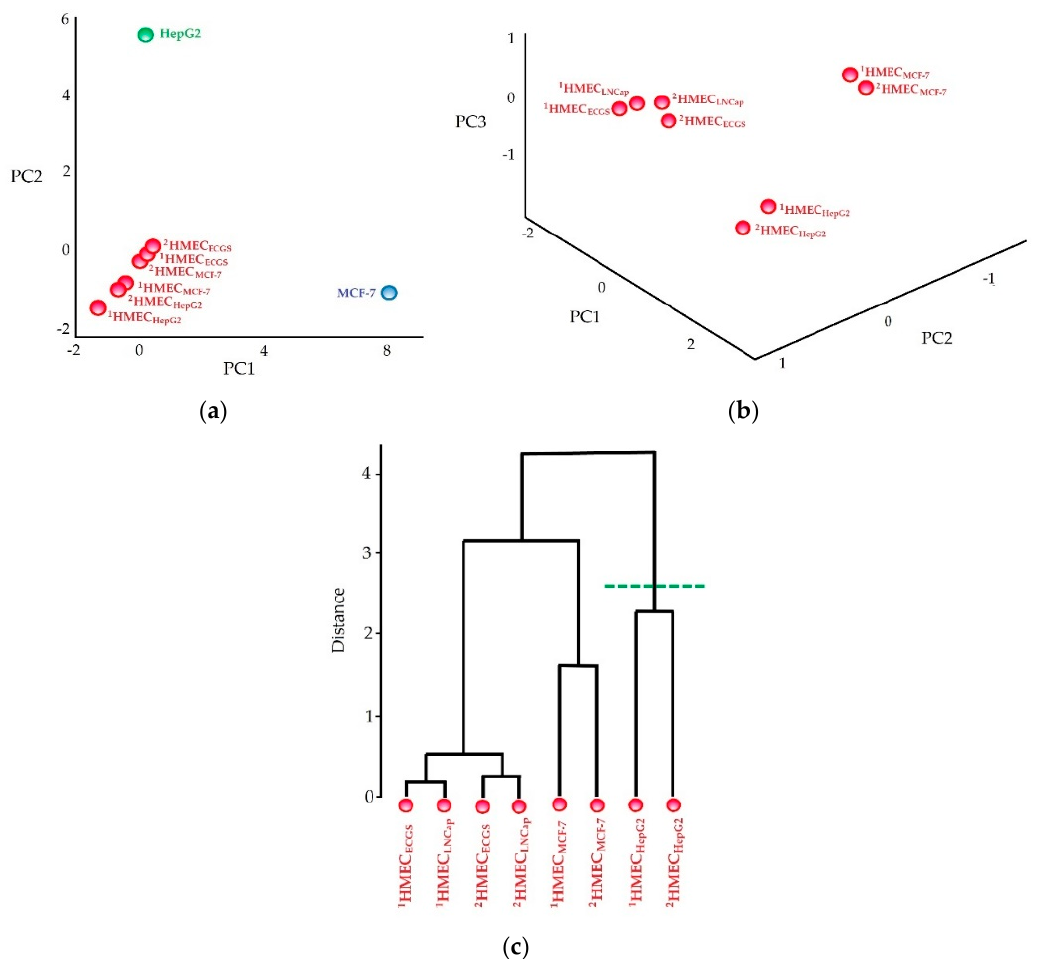
Figure 8. Authentication of antiangiogenic SANTAVAC composition. ( a ) PCA of SANTAVAC codes obtained for HMECs and cancer cells, ( b ) PCA of SANTAVAC codes obtained only for HMECs, ( c ) dendrogram depicting the distances measured between points showed on plot b. “ 1 HMEC ECGS ” and “ 2 HMEC ECGS ”: HMECs stimulated by endothelial cell growth supplement (i.e., by signal from normal cells), “ 1 HMEC MCF-7 ” and “ 2 HMEC MCF-7 ”: HMECs stimulated by MCF-7 cancer cells, “ 1 HMEC LNCap ” and “ 2 HMEC LNCap ”: HMECs stimulated by LNCap cancer cells, “ 1 HMEC HepG2 ” and “ 2 HMEC HepG2 ”: HMECs stimulated by HepG2 cells, “MCF-7”: MCF-7 cells, “HepG2”: HepG2 cells. Green line indicates the cluster considered to be antiangiogenic SANTAVAC, which is qualified for vaccination. Adapted from [90].